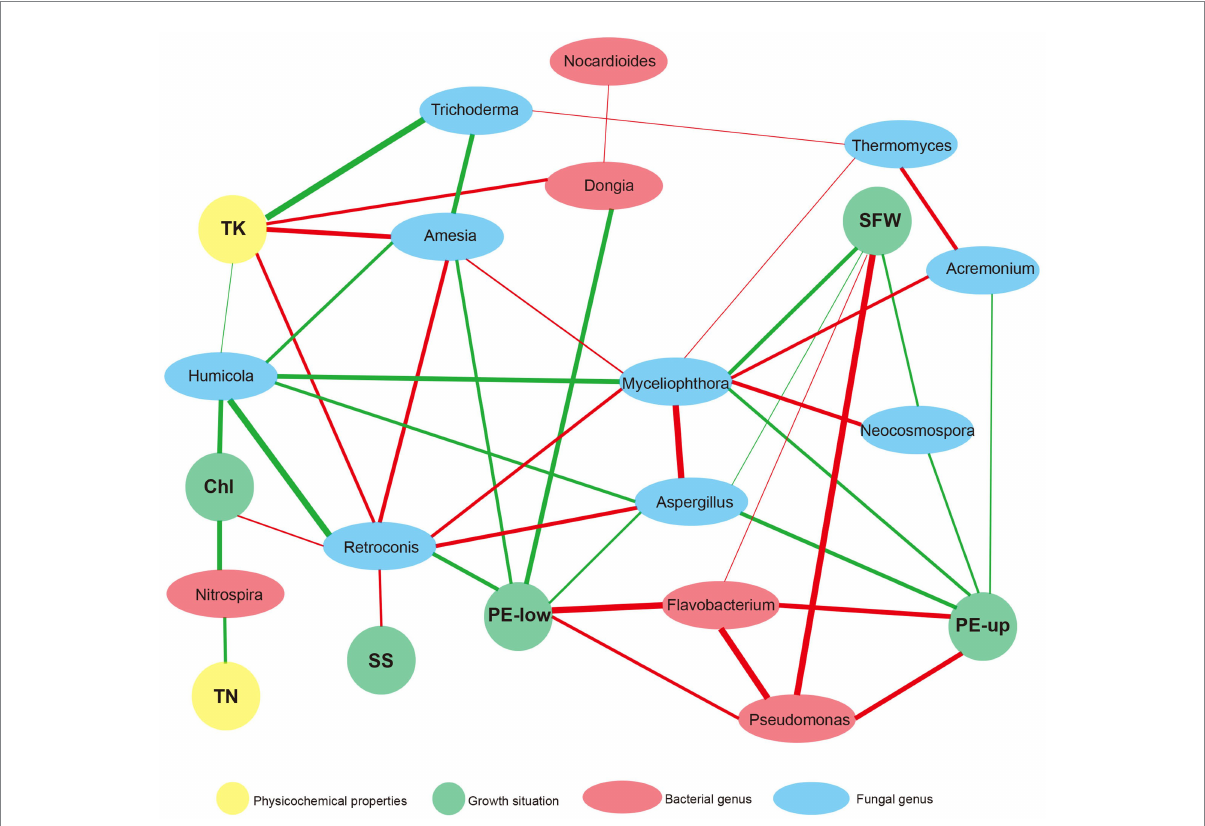
FIGURE 5 Network analysis based on the co-occurrence of physicochemical properties, major microorganisms and the agronomic variables. The agronomic variables, such as PE-up and PE-low leaves, SFW, sugar degree (SS) and chlorophyll content (Chl), were shown in green ellipses. The physicochemical properties, TK and TN were shown in yellow ellipses. The major bacteria, including Dongia , Pseudomonas , Flavobacterium , Nitrospira , and Nocardioides , were shown in red ellipses, and the major fungus, such as Aspergillus , Myceliophthora , Trichoderma , Humicola , Neocosmospora , Retroconis , Acremonium , Amesia and Thermomyces , were shown in gray ellipses. A connection represents a significant correlation ( p < 0.05) according to Spearman’s analysis. The red lines denote positive correlations and the green lines mean negative correlations (the darker the color the stronger the